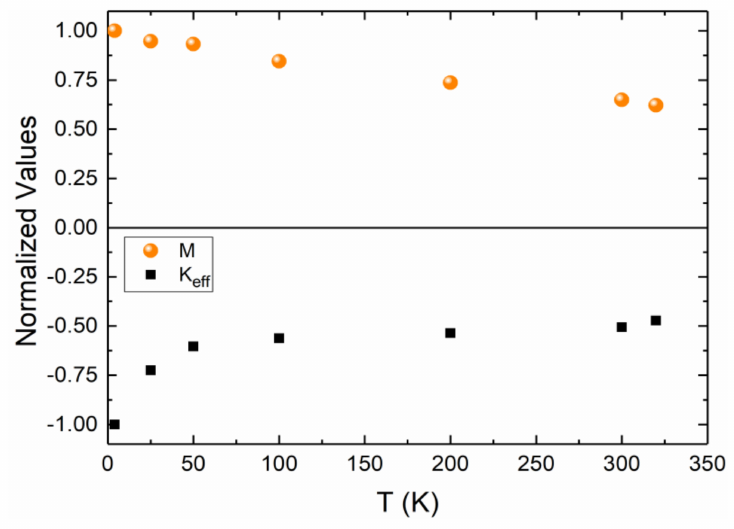
Figure 10. Temperature-dependent magnetizations and anisotropies, as indicated, for the multilayer with t NiFe = 1.8